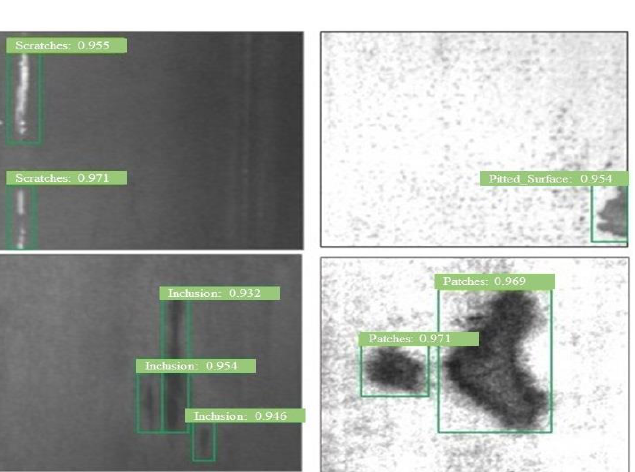
Figure 8. Examples of detection results using DSTEENet on GNEU dataset, green box indicating defect location with confidence score.